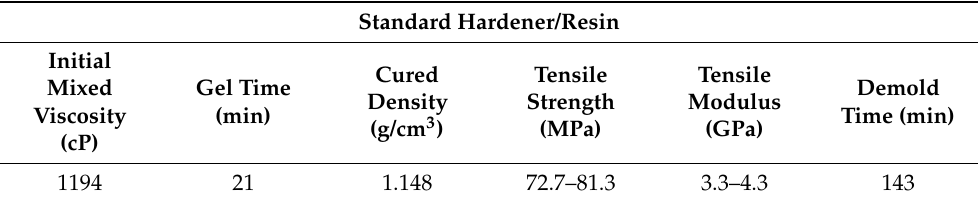
Table 3. Physical and thermal properties of Ampreg 21 (resin and hardener).